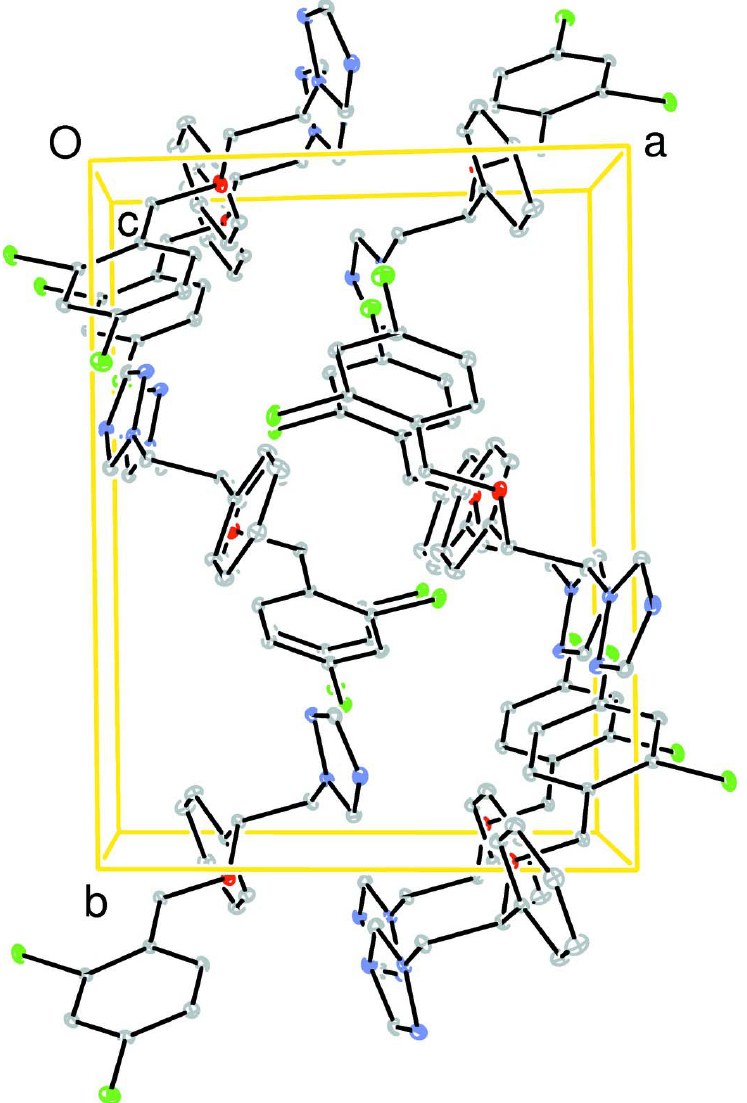
The crystal packing of the title compound, viewed along the c axis. Hydrogen atoms have been omitted for